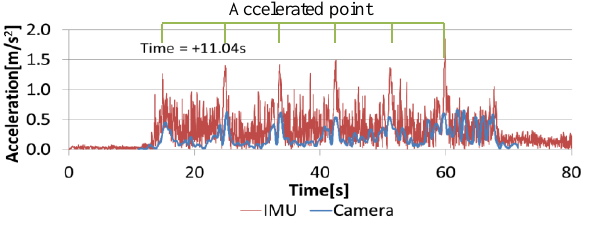
Fig. 14 Synchronizing time of camera and IMU